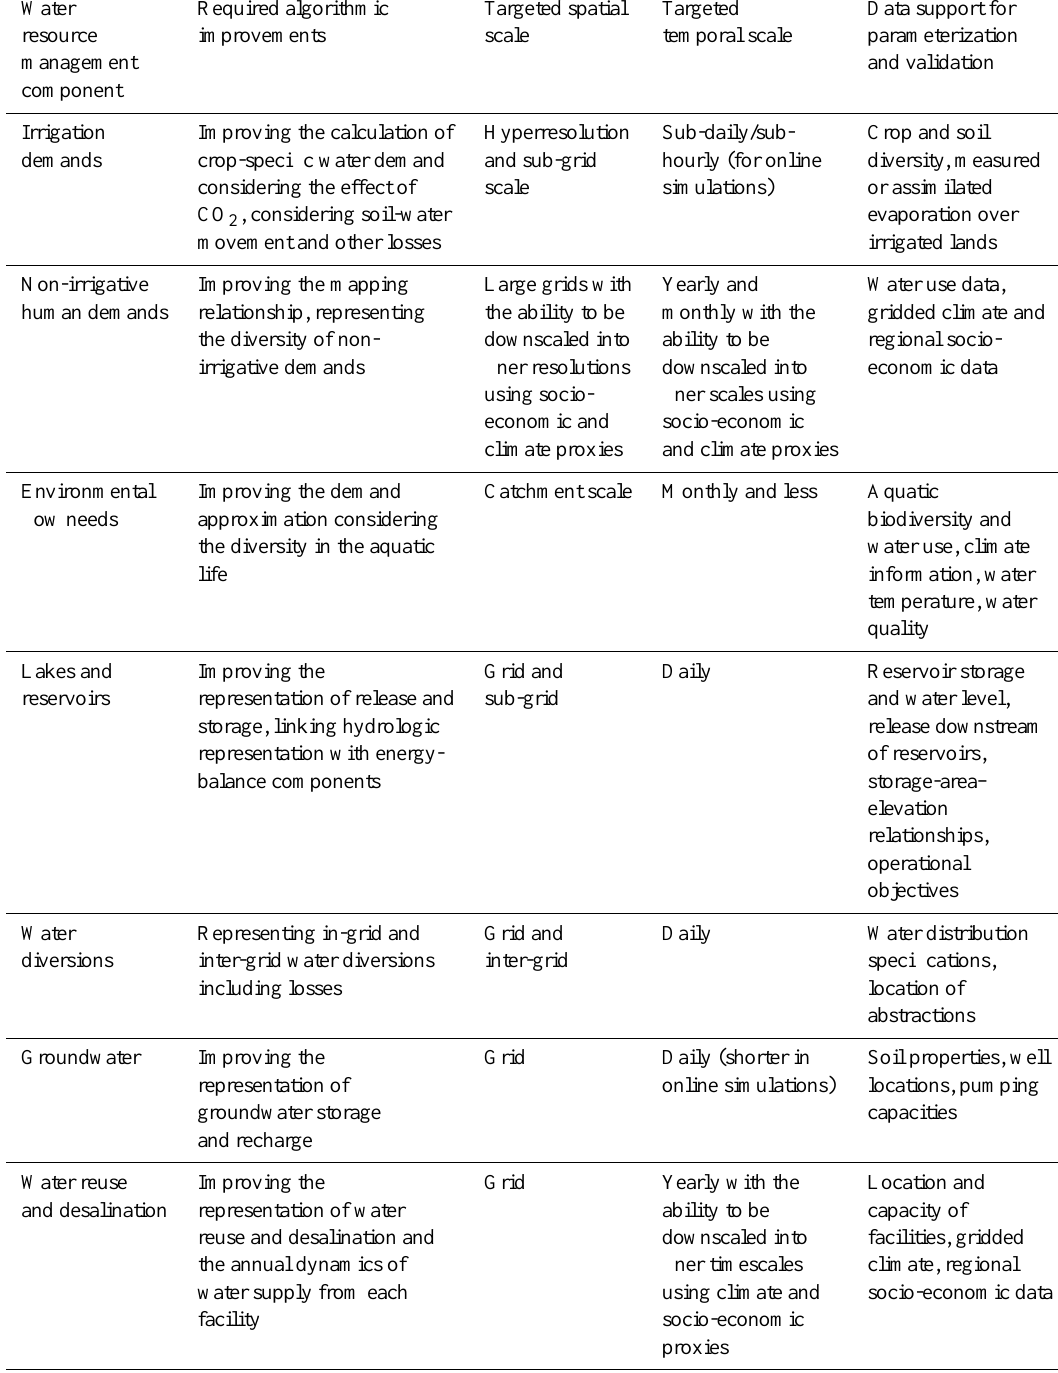
Table 4. Required developments to include the elements of water resource management in Earth system models (see also Table